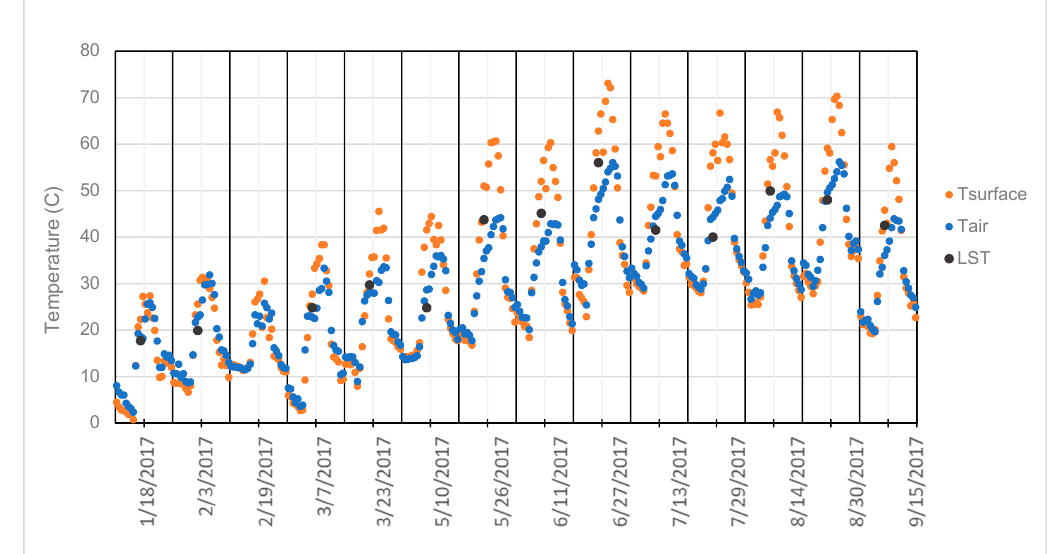
Figure 3. Diurnal T surface and T air for a selected measurement location (27) for all available dates of Landsat image acquisition.